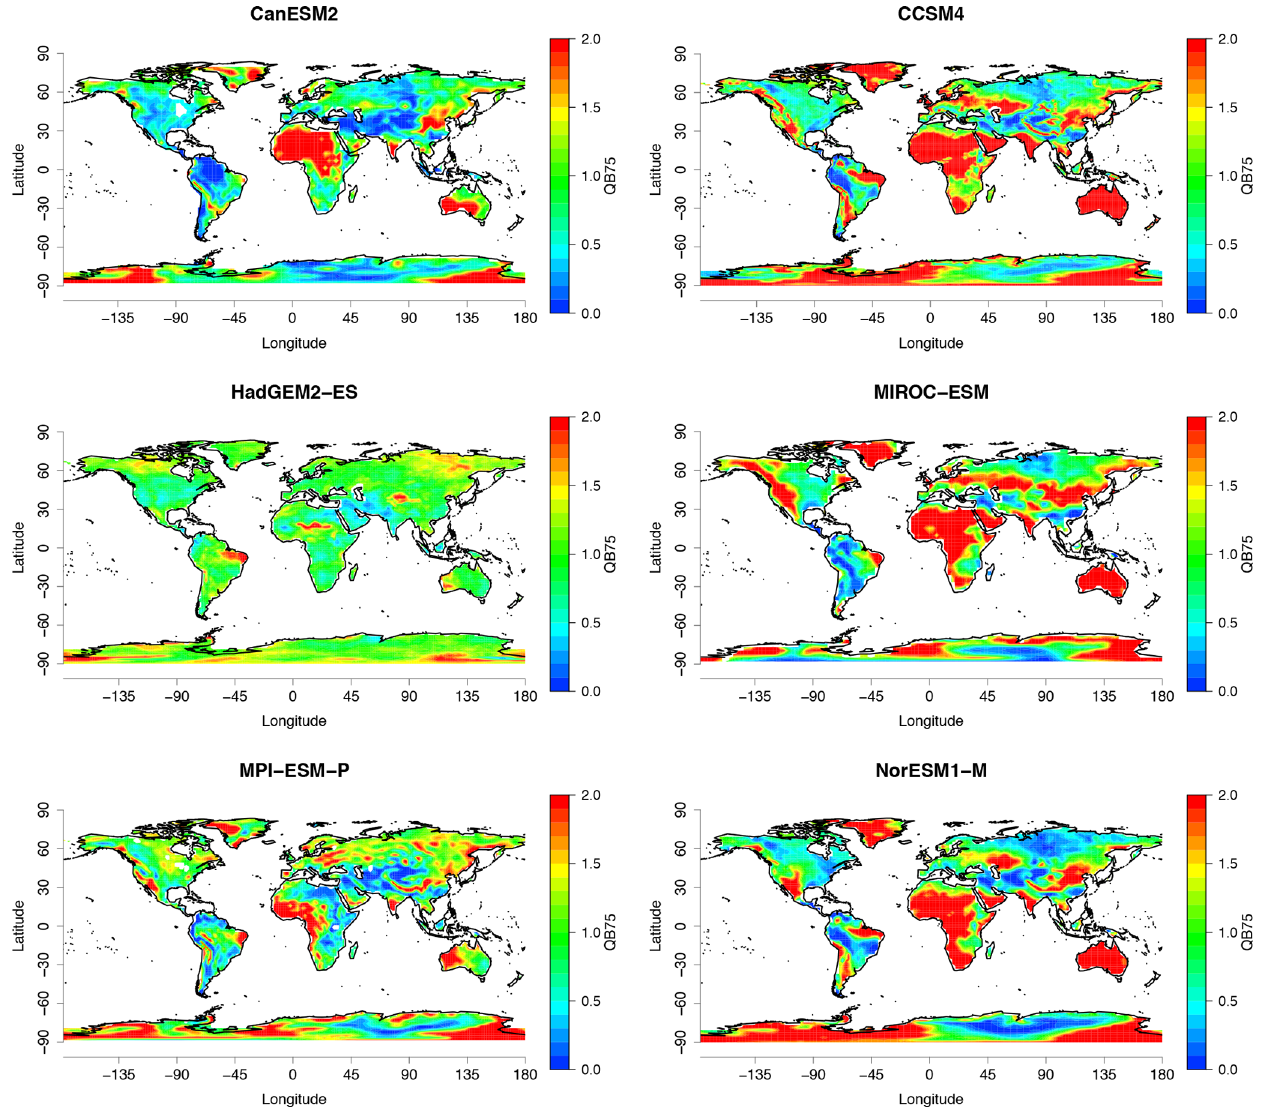
Figure 8. Precipitation quantile bias (75% level, unitless) evaluated for an example subset of CMIP5 models over the period 1979–2005 using GPCP-SG v2.3 gridded precipitation as a reference dataset. Similar to Mehran et al. (2014) and produced with recipe_quantilebias.yml . See details in Sect.